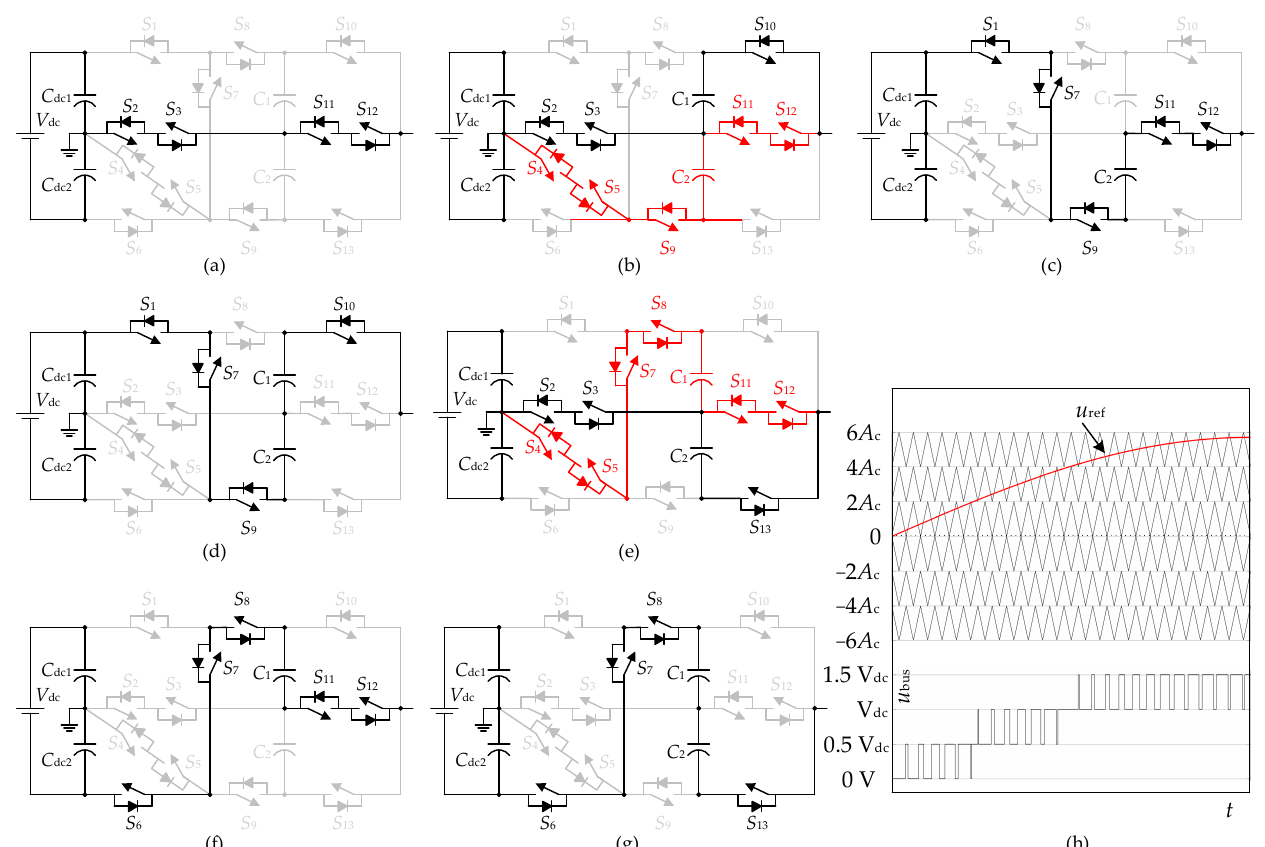
Figure 2. Main switching states of the proposed three-phase SCMLI at ( a ) 0 V, ( b ) 0.5 V dc , ( c ) V dc , ( d ) 1.5 V dc , ( e ) − 0.5 V dc , ( f ) − V dc , and ( g ) − 1.5 V dc . ( h ) The waveform of the phase opposition disposition PWM in the positive quarter cycle (switching frequency f s = 5 kHz).